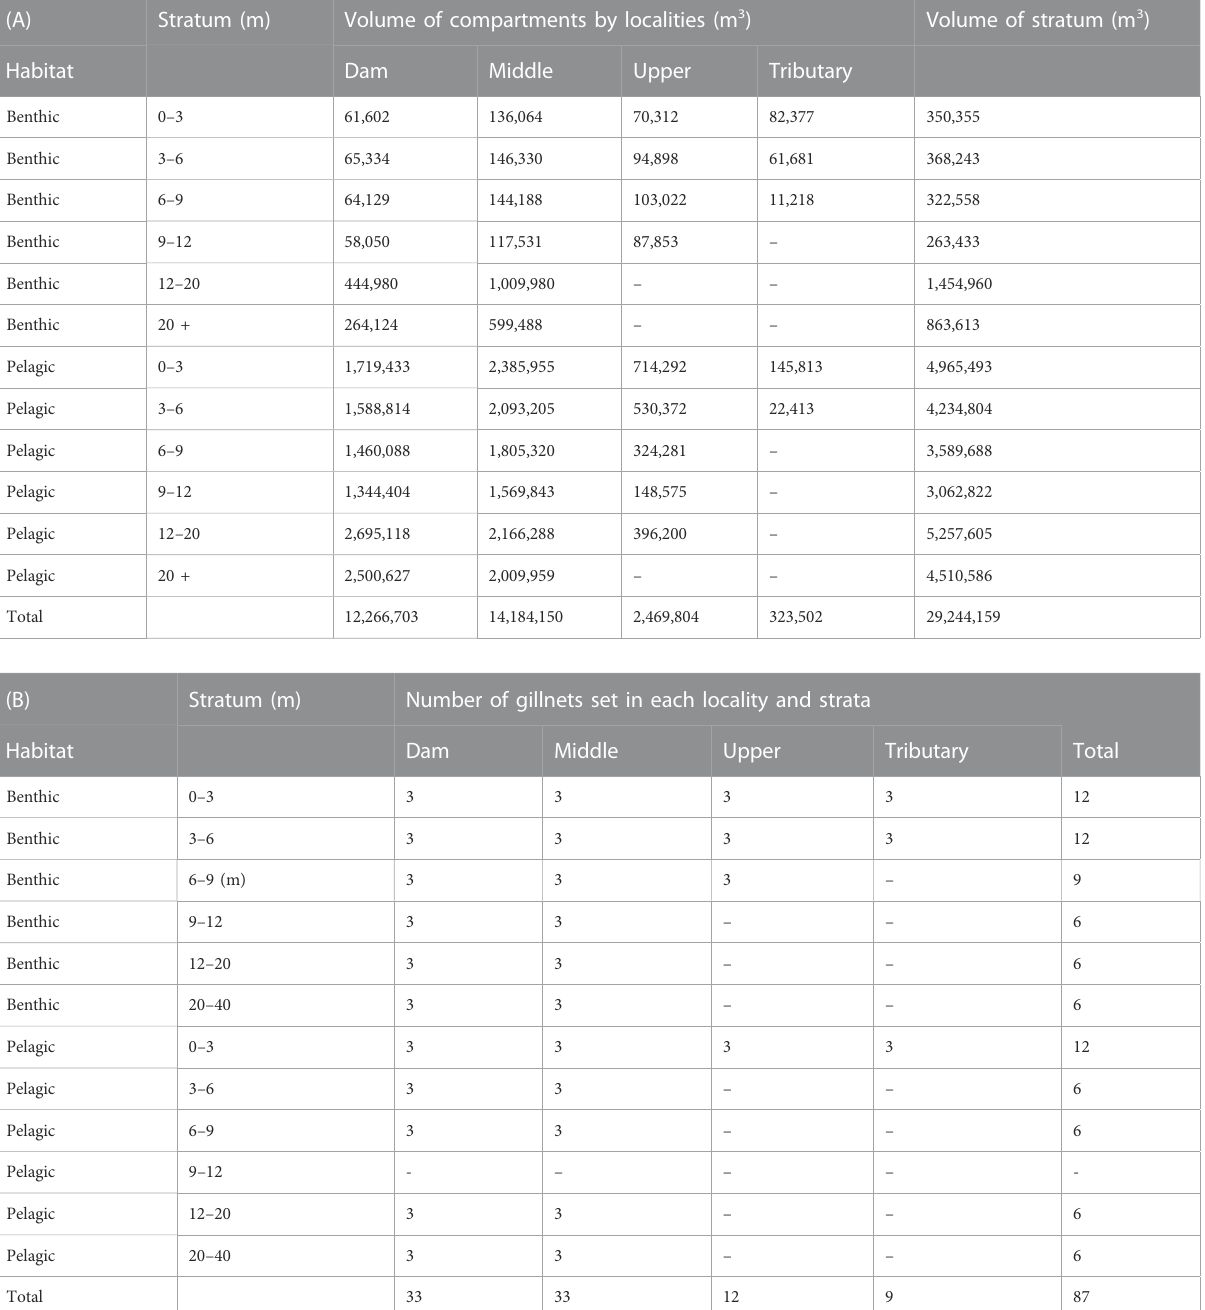
TABLE 2 Volume of depth strata and compartments (A), and the number of gillnets set (B) in different habitats and localities of the Ř ímov Reservoir at 469 m above sea level – the common surface water